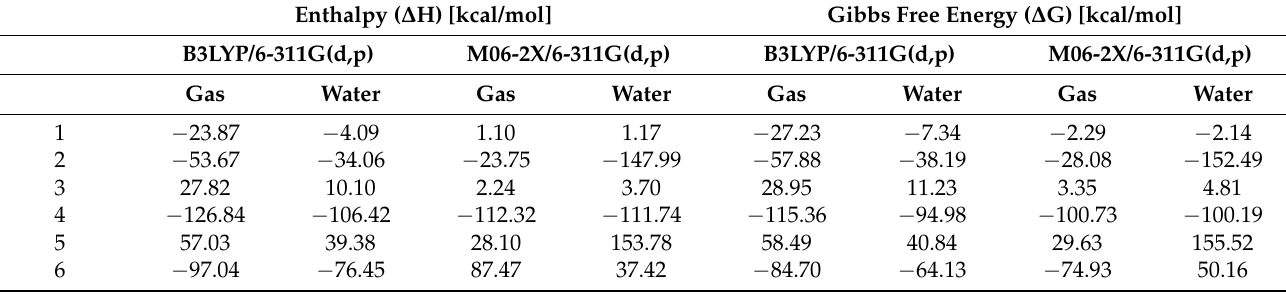
Table 1. Gibbs free energy and enthalpy of the BPA degradation under the Fenton reaction according to Figure 1 calculated at M06-2X/B3LYP/6-311G(d,p) levels of energy in gas and in water solvent (PCM model).